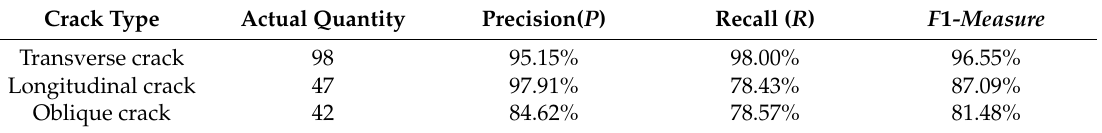
Table 2. Quantitative assessment of the proposed method on three types of